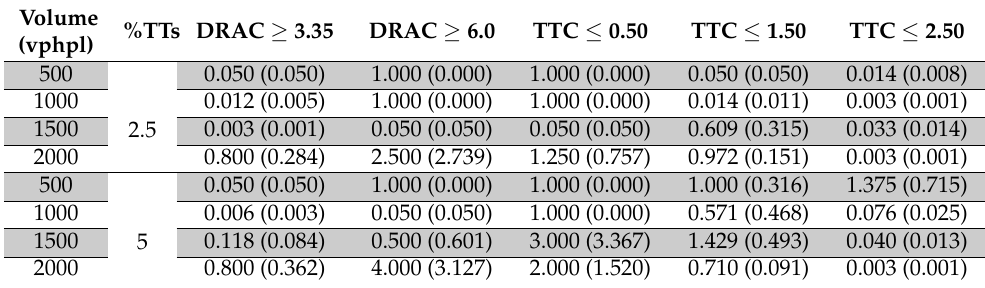
Table 7. Conflict ratio between TT speed of 60 km/h before and TT speed of 90 km/h after for PC speed limit of 90